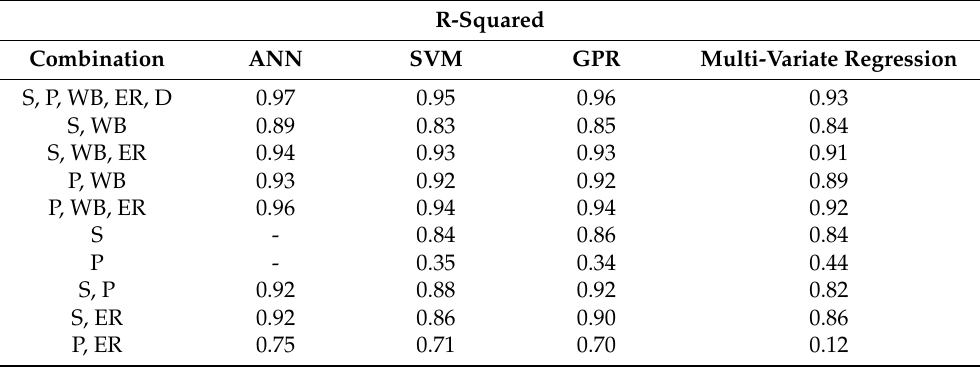
Table 10. R-squared comparison between the different methods used in the